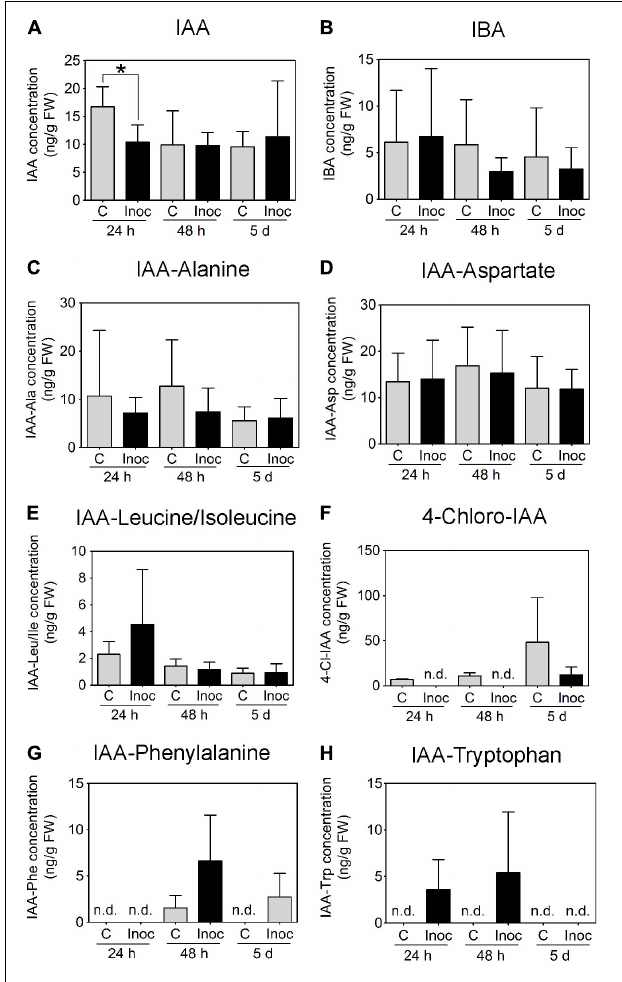
FIGURE 8 | Auxin content in developing L. japonicus nodules (4 mm long segments around the inoculation site). Endogenous auxin concentration (ng g − 1 FW) in L. japonicus roots inoculated with M. loti - or mock-treated roots was measured at 24 h, 48 h, and 5 days post-inoculation. Auxins detected in L. japonicus roots include (A) IAA, (B) IBA, (C) IAA-Ala, (D) IAA-Asp, and (E) IAA-Leu/Ile. (F) 4-Cl-IAA, (G) IAA-Phe, and (H) IAA-Trp were not consistently detected at all time points. A two-way ANOVA and a Student’s t -test were used for statistical analyses ( p < 0.05; n = 3–6 per treatment or time point). Asterisk in (A) indicates a significant difference in auxin concentration ( p < 0.05). Graphs show mean and SD. Abbreviations: FW, fresh weight; C, control; Inoc, inoculated; n.d., not detected; IAA, indole-3-acetic acid; and IBA, indole-3-butyric